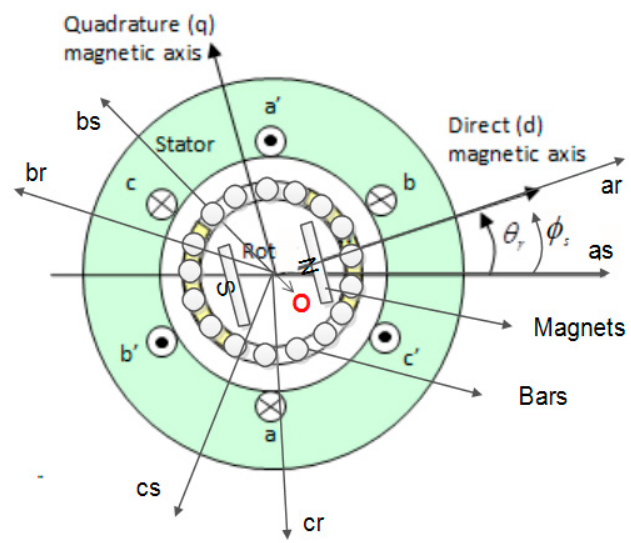
Figure 1. Stator and rotor circuits of Line ‐ Start Permanent Magnet Synchronous (LSPMS) motor.